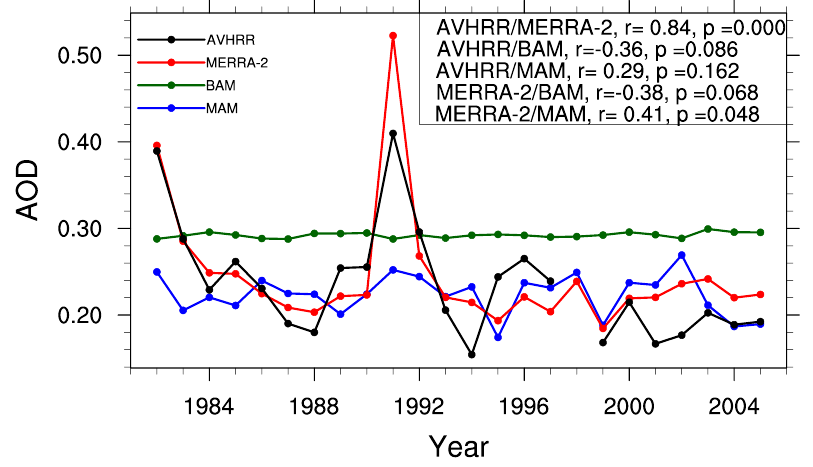
Figure 6. Interannual variability in aerosol optical depth for observations, AVHRR and MERRA-2, and models, BAM and MAM. Calculated over the seasonal (June – November) and MDR from 1982 to 2005. Inset shows correlation (r) and statistical significance ( p ) values for observations and models.